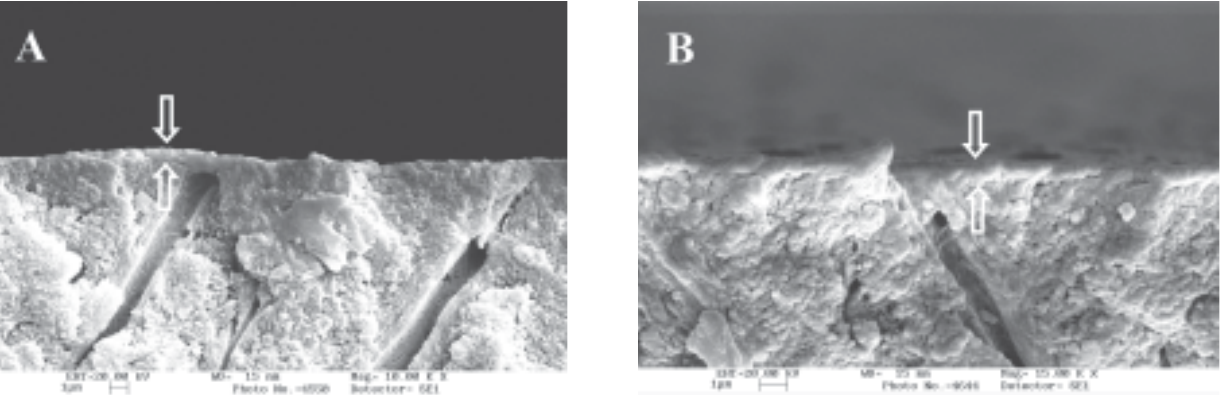
FIGURE 3- SEM micrograph of HEMA and glutaraldehyde-treated dentin. A thin layer can be seen over the dentin (between arrows), occluding the entrance of dentinal tubules. (A: x 10,000; B: x 15,000)